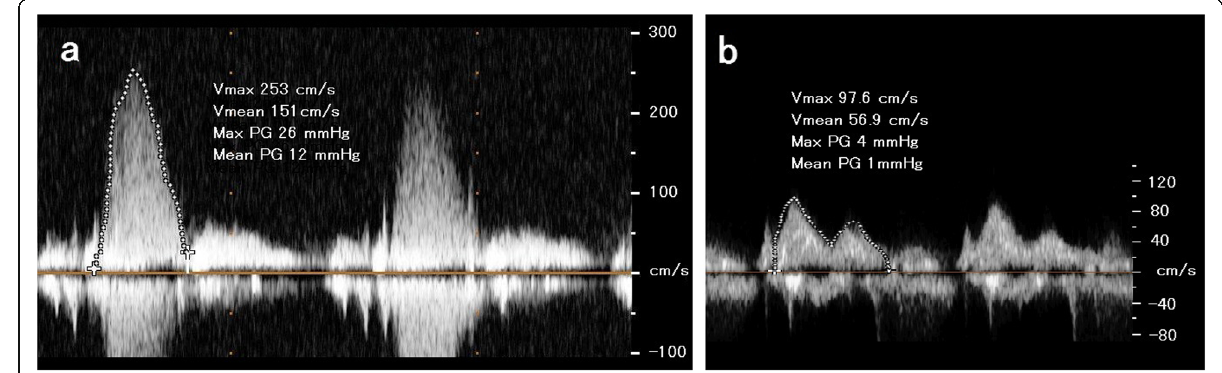
Fig. 2 a Transaortic echocardiography pressure peak gradient, measured by continuous wave Doppler across the left ventricular outflow tract before surgery. b Transaortic echocardiography pressure peak gradient measured by continuous wave Doppler across the left ventricular outflow tract after surgery. Vmax, maximum flow velocity; Vmean, mean flow velocity; Max PG, maximum pressure gradient; Mean PG, mean pressure